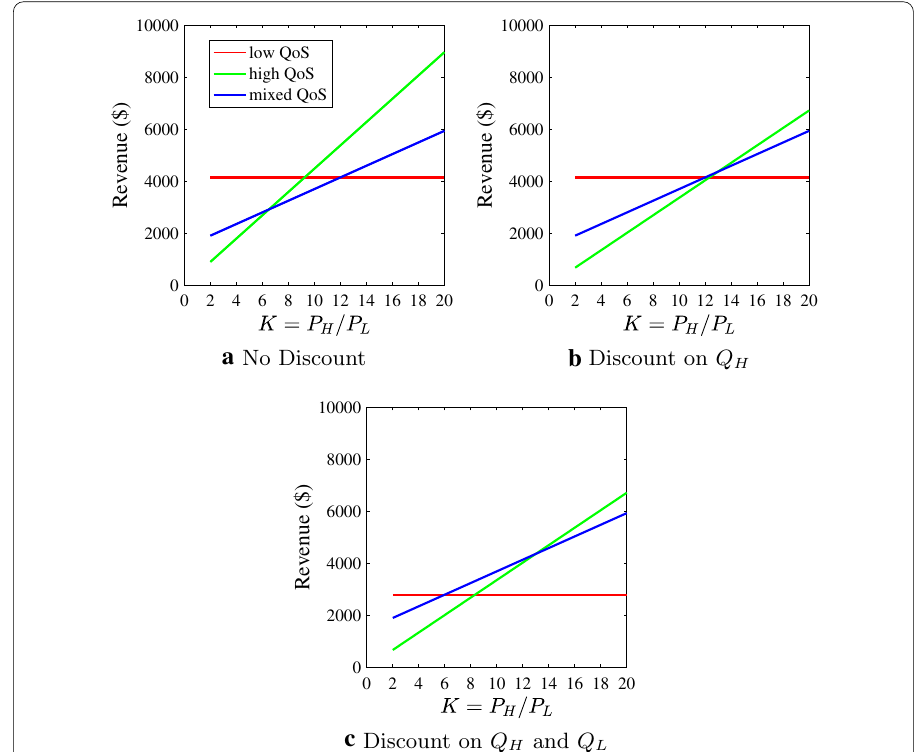
Fig. 4 Revenue for the three QoS scenarios for the cases with (i) no discount, (ii) 50% discount for N H − N H , M high QoS users, (iii) discount as in (ii) along with 20% discount for N L − N L , M low QoS users. Technical parameters: f 3800 MHz, indoor. The choice of the QoS class is =